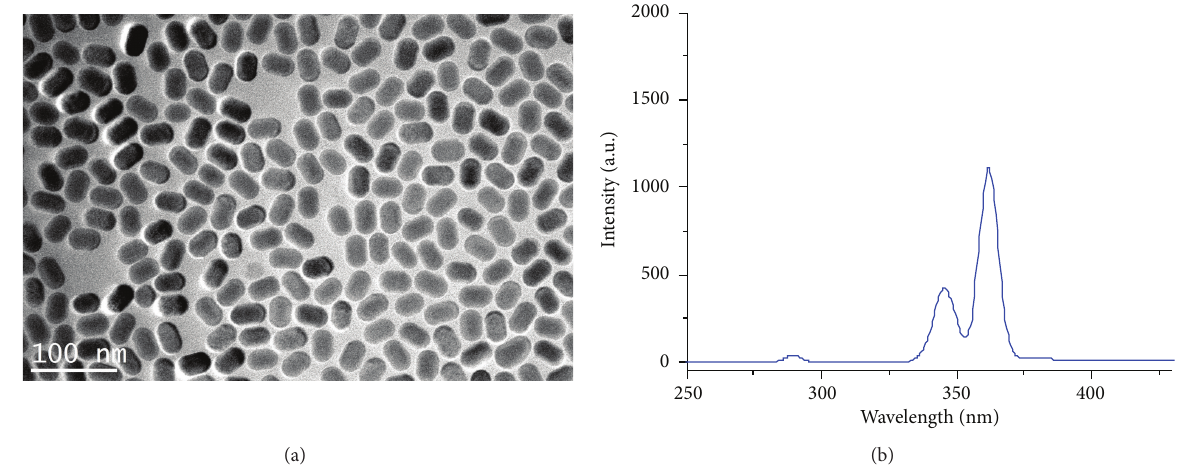
Figure 6: (a) TEM micrographs of the NaYF 4 :Tm 3+ 0.5 mol%, Yb 3+ 30 mol%@ NaYF 4 core/shell UCNPs; (b) emission spectra of UCNPs under 980 nm NIR excitation (8